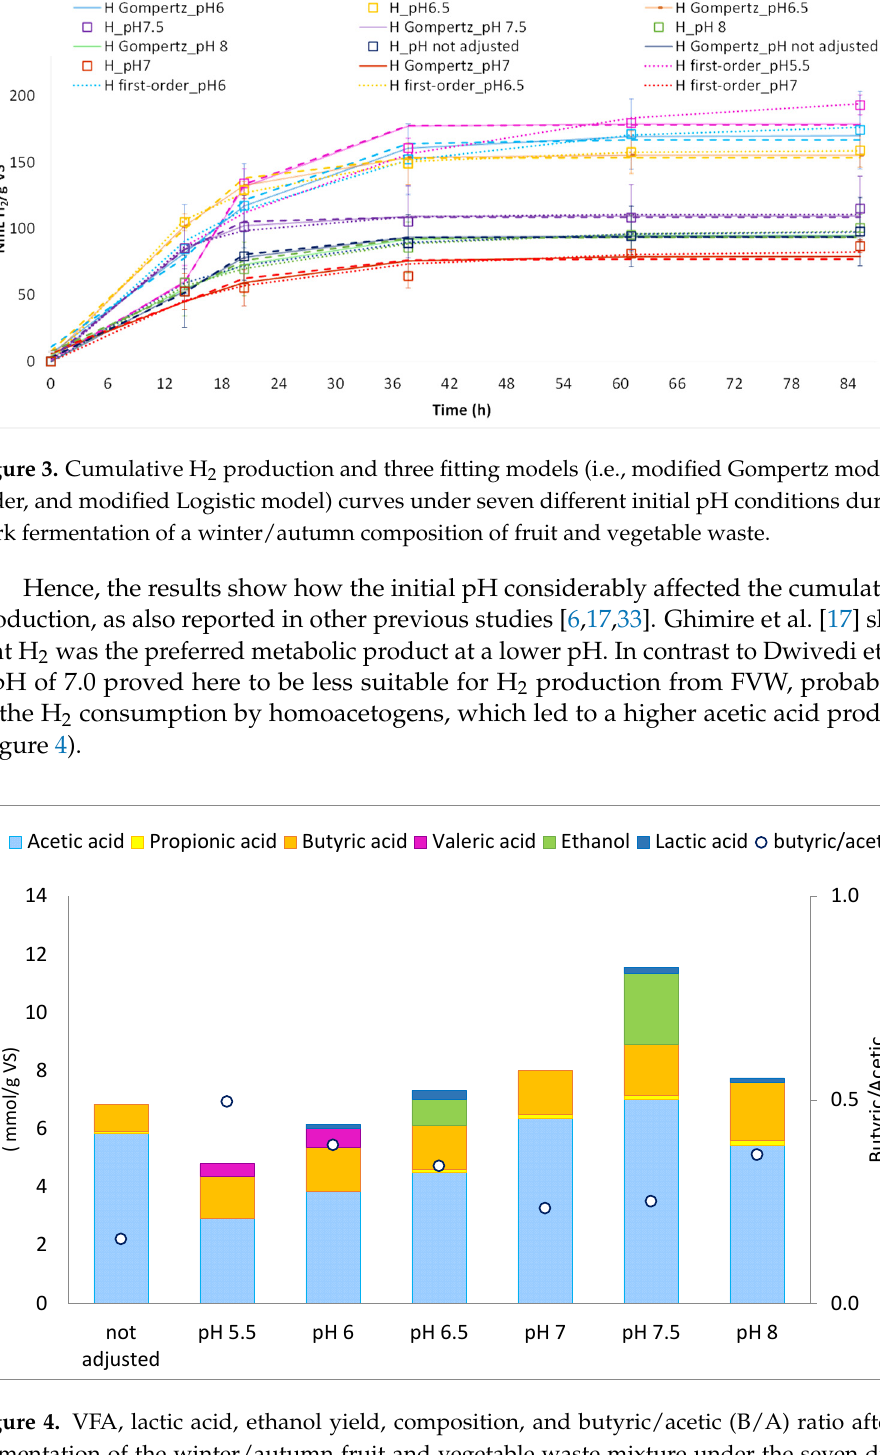
Figure 4. VFA, lactic acid, ethanol yield, composition, and butyric/acetic (B/A) ratio after dark fermentation of the winter/autumn fruit and vegetable waste mixture under the seven different initial pH conditions investigated.